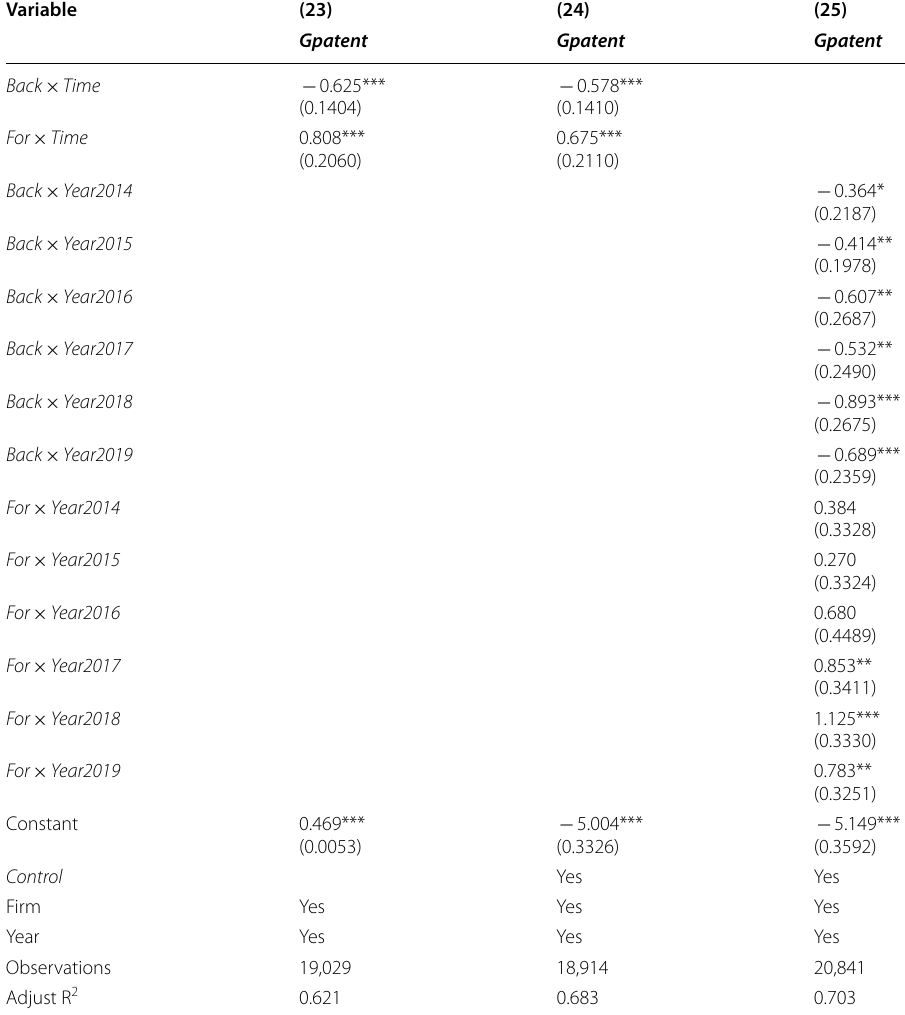
Table 7 Conduction effect